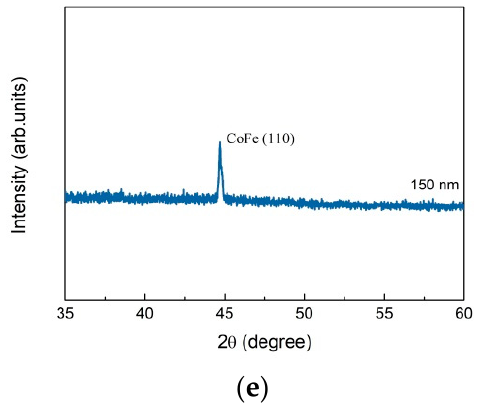
Figure 1. X-ray diffraction patterns of Co 40 Fe 40 W 10 B 10 thin films: ( a ) post-annealing at 200 °C, ( b ) post-annealing at 250 °C, ( c ) post-annealing at 300 °C, ( d ) post-annealing at 350 °C, and ( e ) post-annealing at 400 °C with 150 nm.